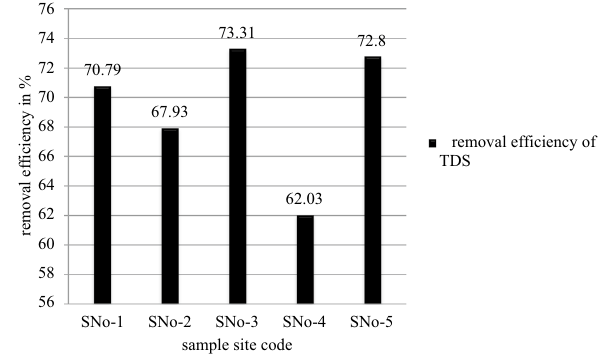
Fig. 5 Turbidity removal efficiency of chlorination from, water